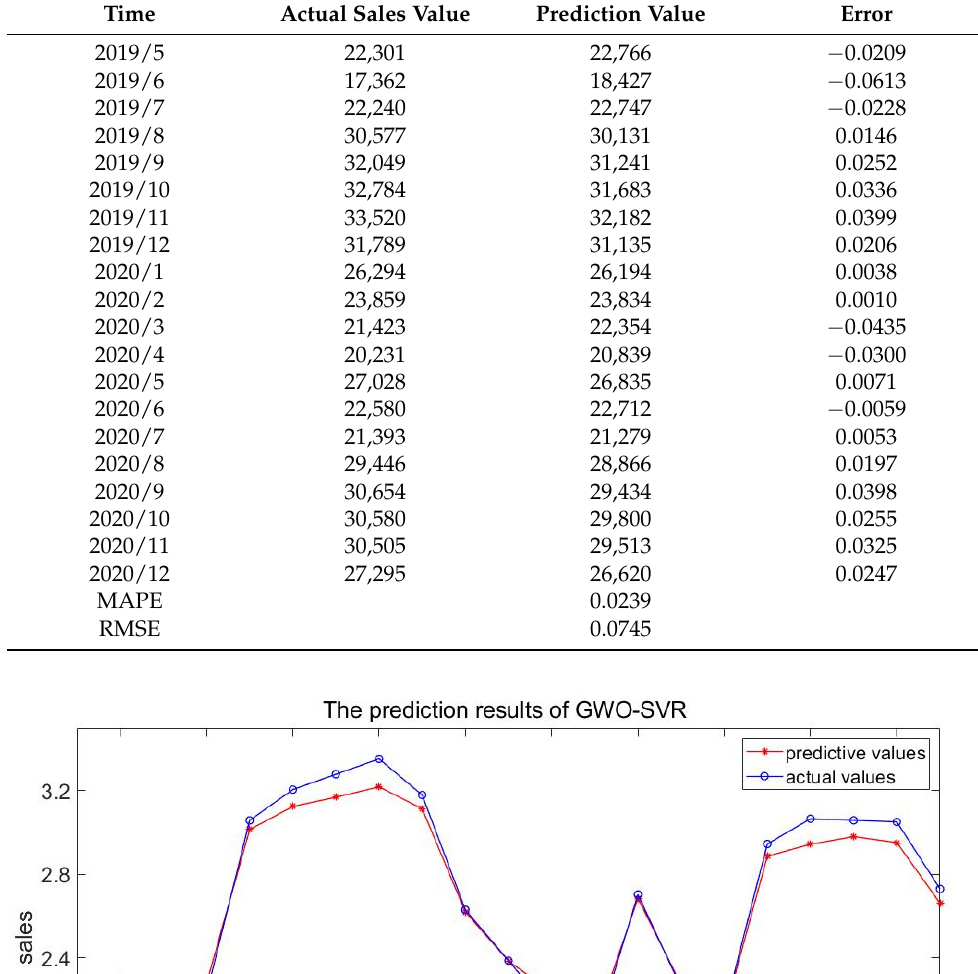
Table 3. The model fitted the prediction results of Suteng.